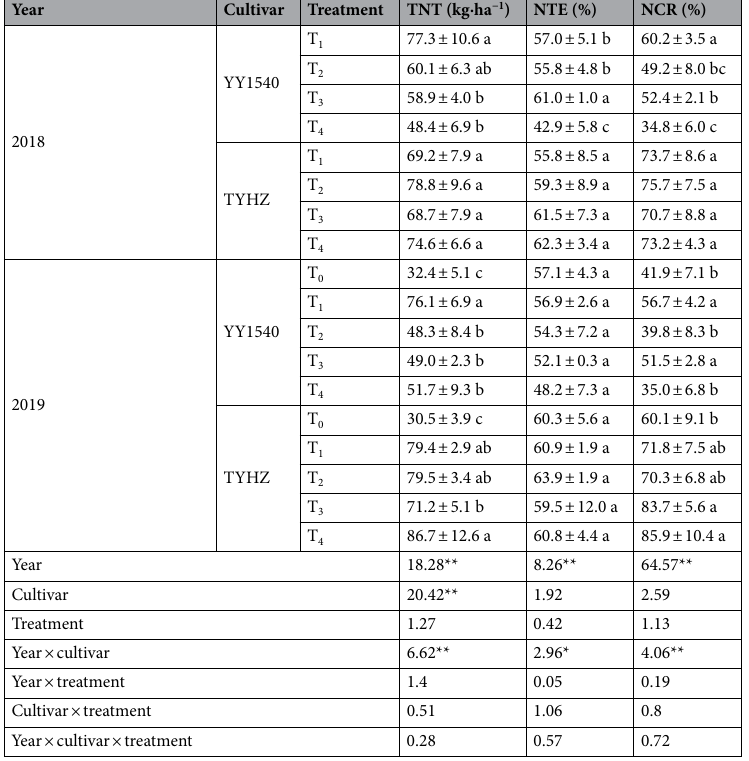
Table 4. Nitrogen transport under four nitrogen fertilization treatments in indica – japonica hybrid rice (‘Yongyou1540’, YY1540) and indica hybrid rice (‘Tianyouhuazhan’, TYHZ). Values followed by different lower- case letters within the same column are significantly different among treatments.* p < 0.05; ** p < 0.01. TNT nitrogen amount transport from stem, sheaths and leaves to panicles, NTE nitrogen apparent translocation efficiency of the stem, sheaths and leaves, NCR rate of contribution of transferred nitrogen into grains.